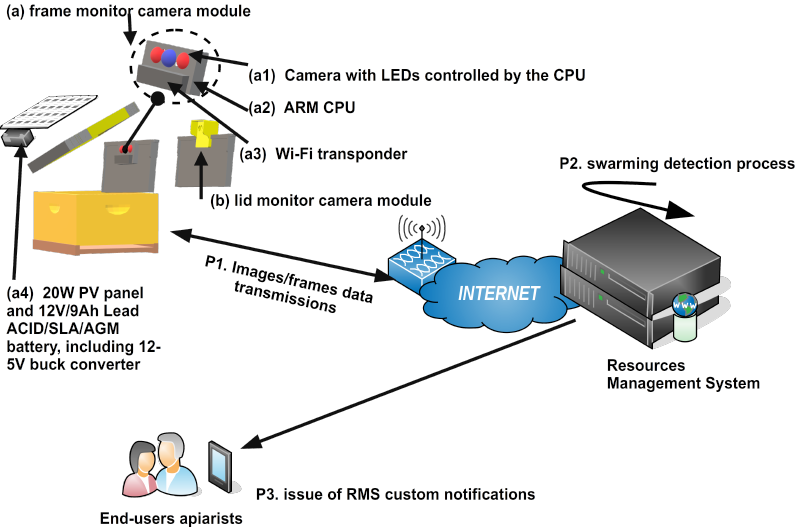
Figure 1. Beehive monitoring end node Version 1 device that includes a WiFi transponder and the beehive-monitoring system logic using v1 end node